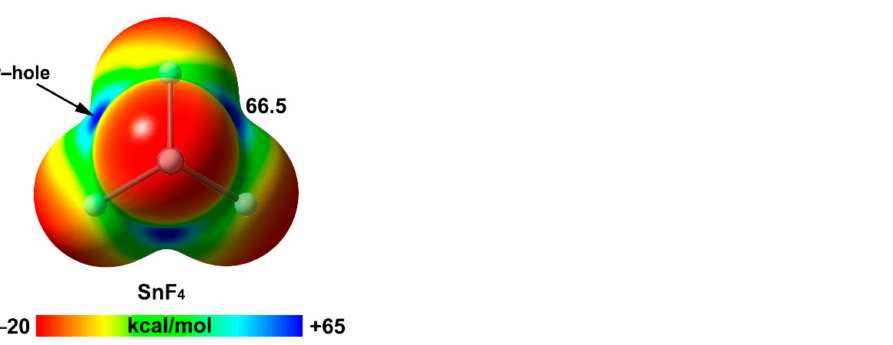
Figure 2. MEP surface of SnF 4 using the 0.001 a.u. isosurface and the MP2/def2-TZVP level of theory (energy in